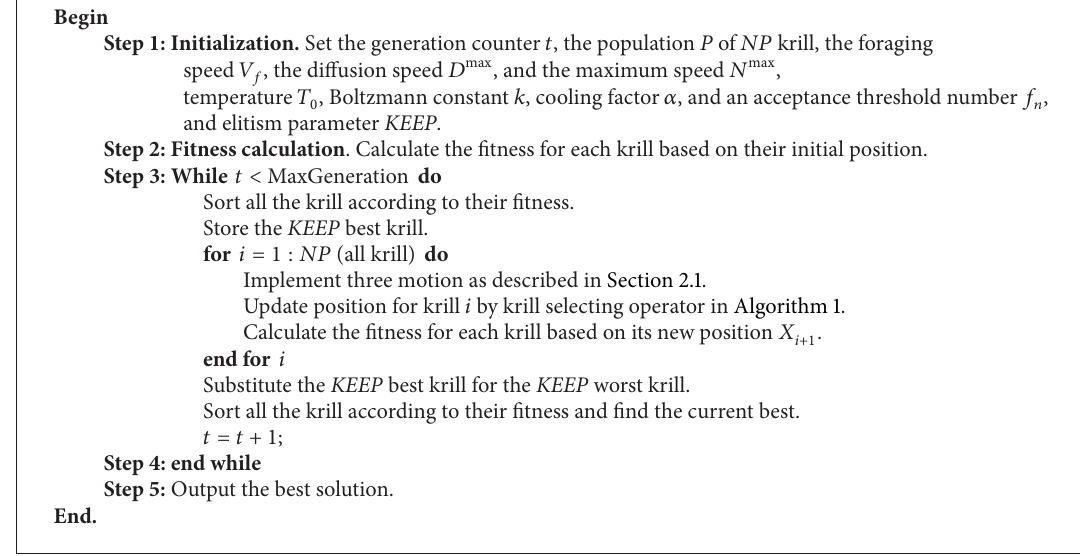
Algorithm 2: Simulated annealing-based krill herd